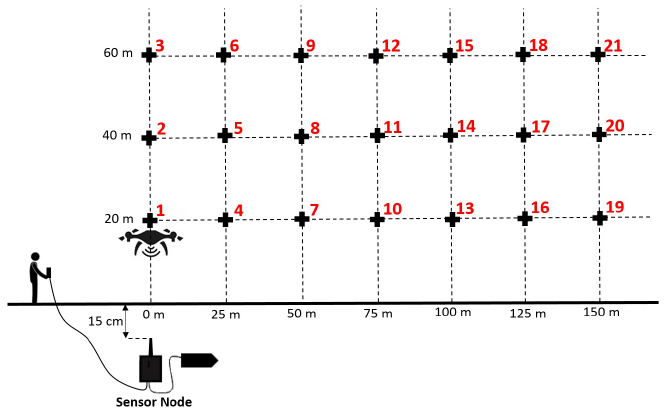
Figure 9. Experimental setup in hovering mode to study the UG2AIR communication link. The UAV is stabilized for several seconds at different altitudes (20, 40, and 60 m) and lateral distances (0 to 150 m by steps of 25 m). At each position, the buried sensor node sends 100 data frames. The collector node measures the RSSI signals and collects the data